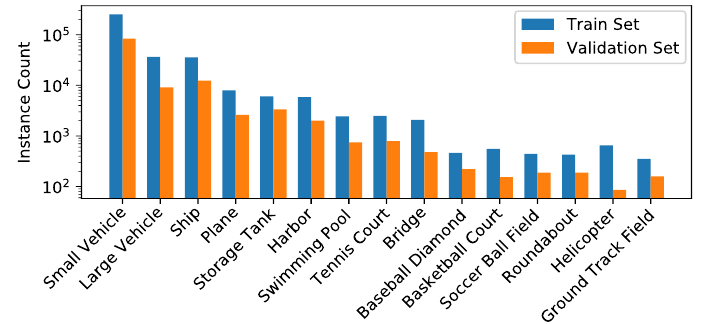
Figure 3. Distribution of object sizes in iSAID [52] ( a ) and MS-COCO [57] ( b ). The distribution of iSAID is heavily skewed towards small objects. Thus a focus on the small objects is needed. However, even though large objects are rare, each of them is more important for the average precision since they are typically in rare classes. This discrepancy combined with the many small and thus hard to detect objects poses a major challenge for the detector.